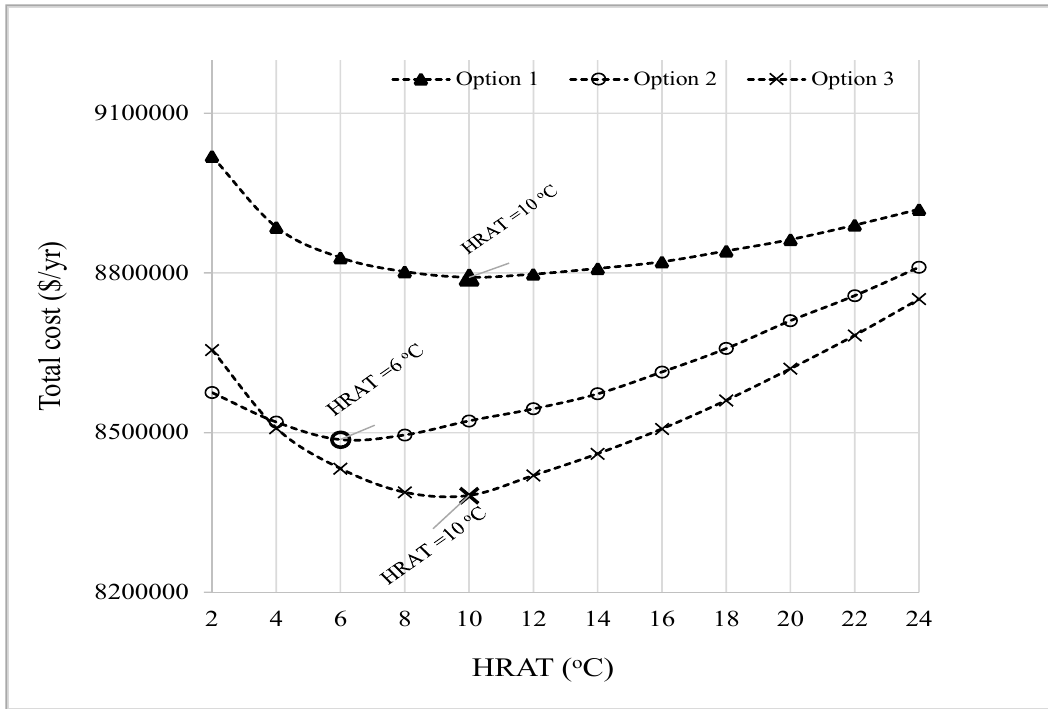
Figure 4. Total cost targeting profile for the three options.